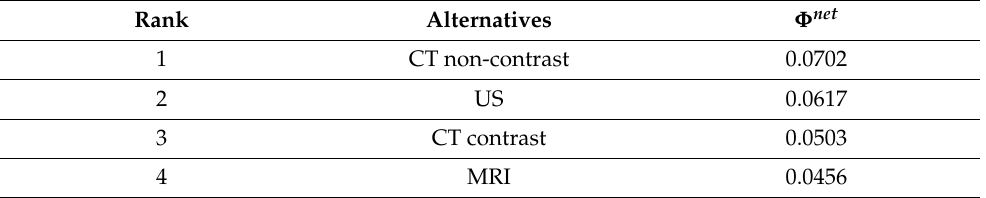
Table 5. Ranking of the acute appendicitis diagnosis for high AIR score by F-PROMETHEE approach.